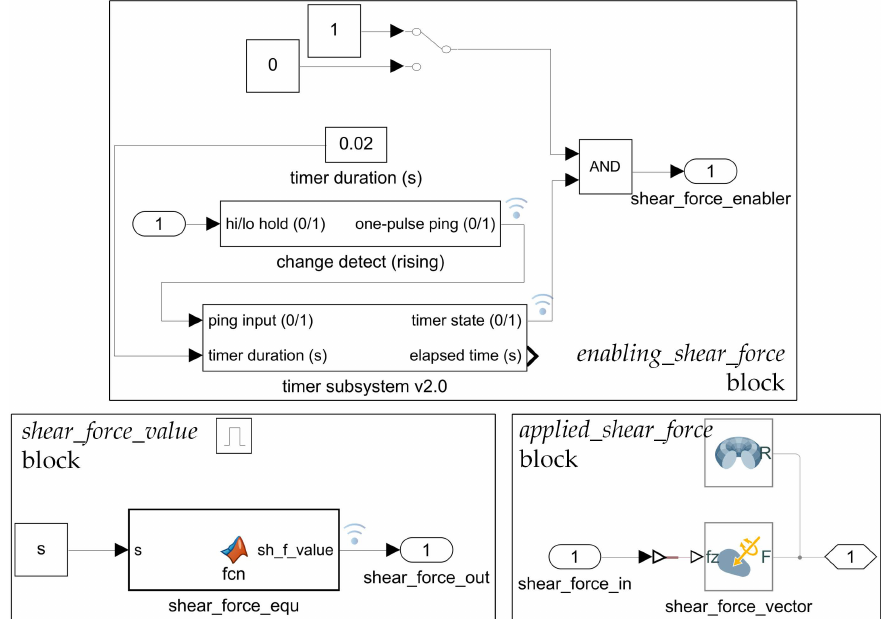
Figure 11. Blocks for calculating, enabling, and applying the shear force